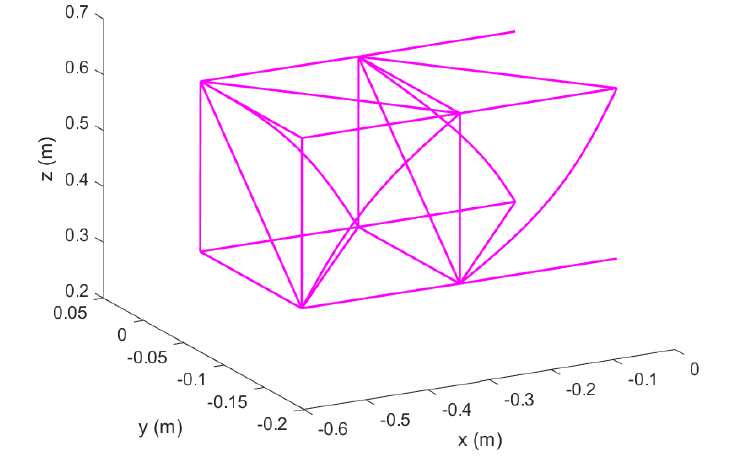
Figure 29. Mode 4 of Timoshenko beams in Topology 1 with hinged ends; original configuration.